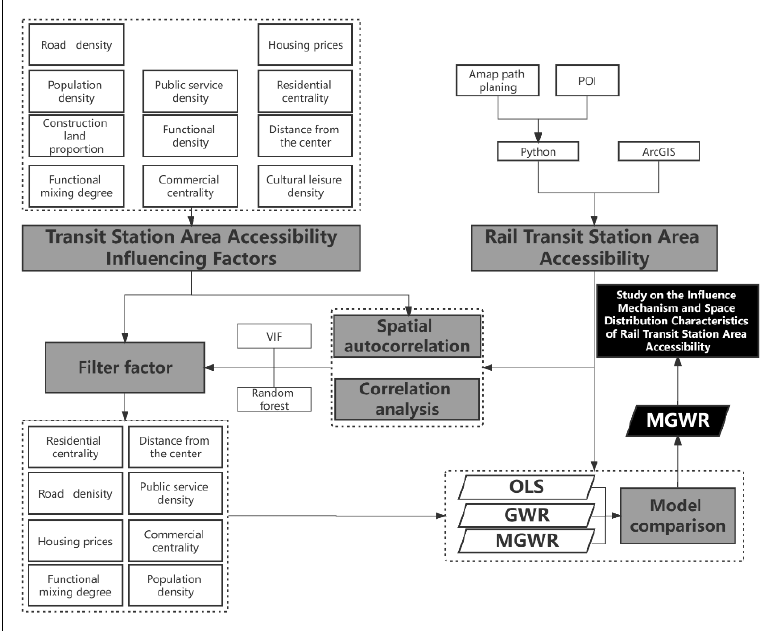
Figure 2. Research framework.